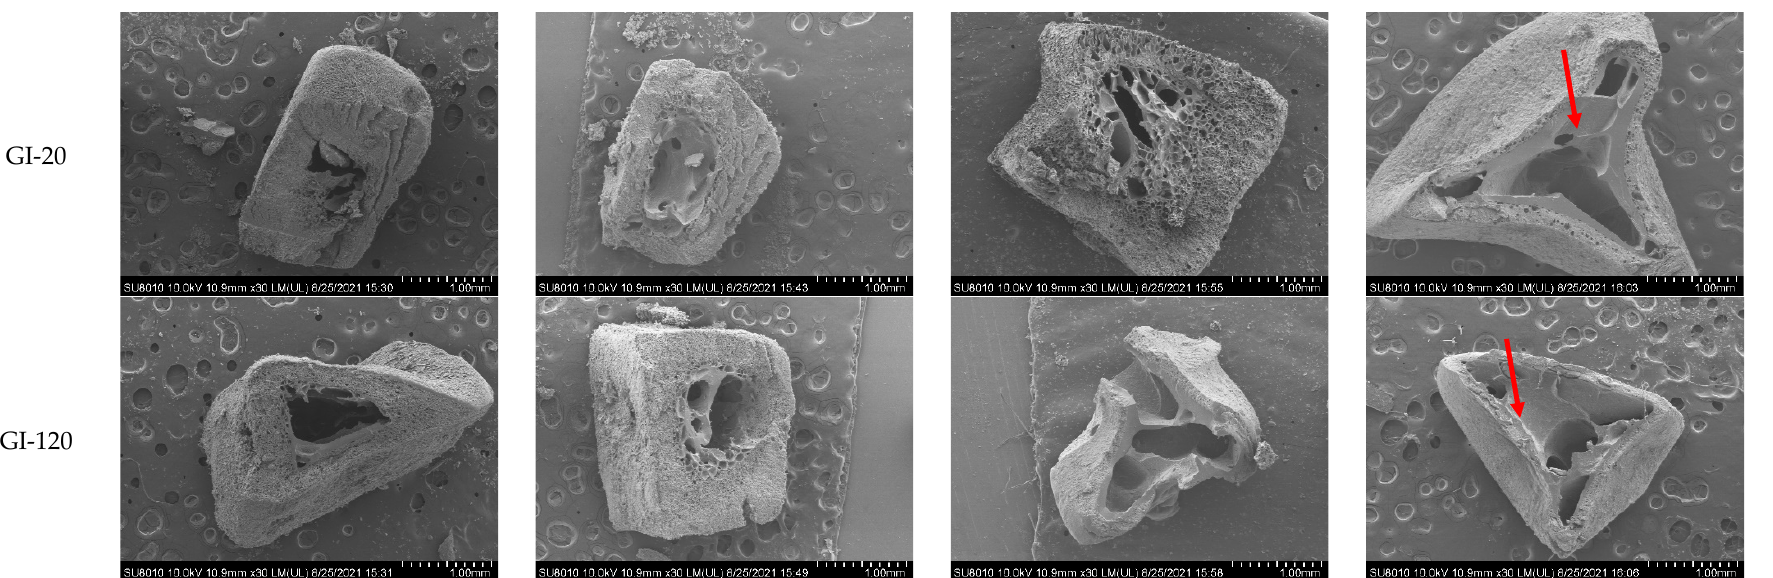
Figure 2. SEM images (30×) of the fracture surface of the cold and hot extruded noodles without or with phenolics before digestion (uncooked and cooked) and residues during simulated in vitro gastrointestinal digestion for 0, 20, and 120 min. CE-S, cold extruded noodles with starch only; CE-S-P2, cold extruded noodles with starch and phenolics (2.0%); HE-S, hold extruded noodles with starch only; HE-S-P2, hold extruded noodles with starch and phenolics (2.0%); BD-UC, uncooked noodles before digestion; BD-C, cooked noodles before digestion; GI-0, gastrointestinal digestion for 0 min (after gastric digestion); GI-20, gastrointestinal digestion for 20 min; GI-120, gastrointestinal digestion for 120 min.